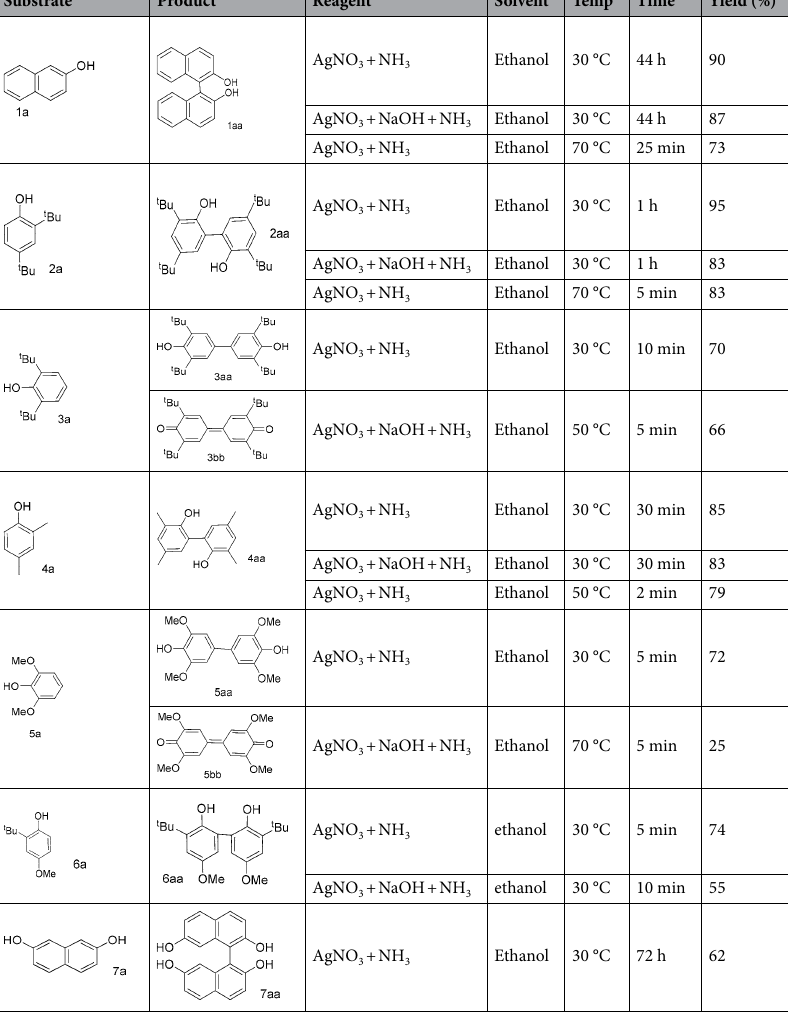
Table 1. Oxidative C–C homo-coupling of substituted phenols. Isolated yield of column purified product is reported. Typical reaction parameters are—AgNO 3 (0.2 mmol), liquor ammonia (0.2 ml), substrate (0.2 mmol), absolute ethanol (0.5